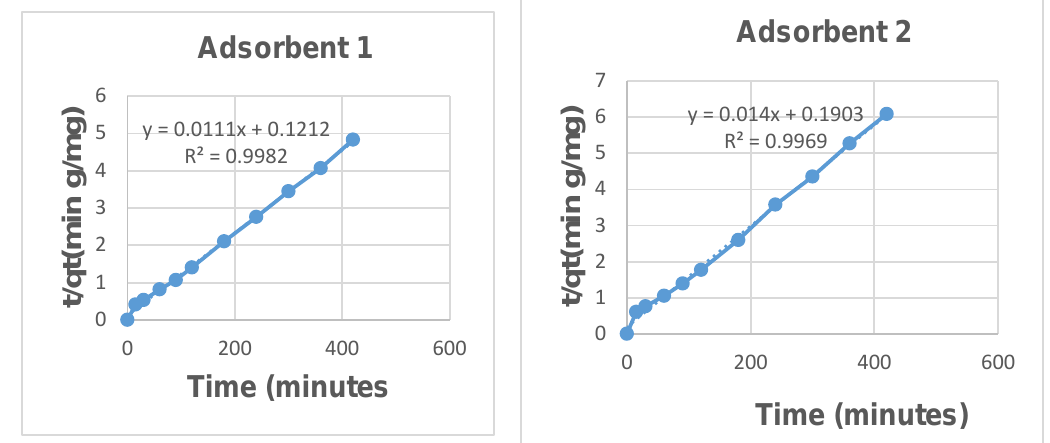
Figure 16. Lagergren pseudo-second-order kinetics adsorption for Pb(II) onto adsorbents 1 and 2 (Experimental conditions: pH 6.5 ± 0.2, initial metal concentration = 20 mg/L, dosage = 50 mg/50 mL, mixing rate = 50 rpm, T = 25 °C). Table 4. Coe ffi cients of sorption kinetics (Lagergren’s pseudo-second-order model) for Pb (II) removal by adsorbents 1 and 2 and their correlation coe ffi cient (R 2 ). (Experimental conditions: pH 6.5 ±